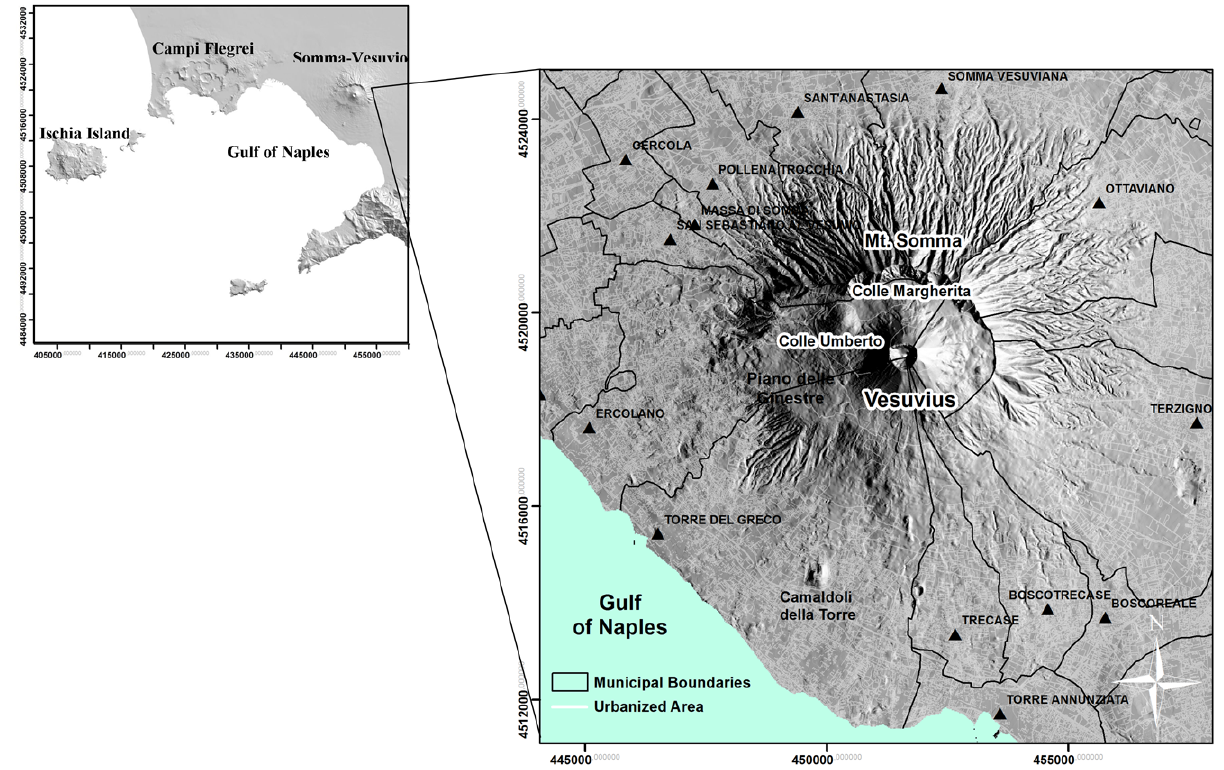
Figure 1. Location and shaded relief of the Somma-Vesuvius volcanic